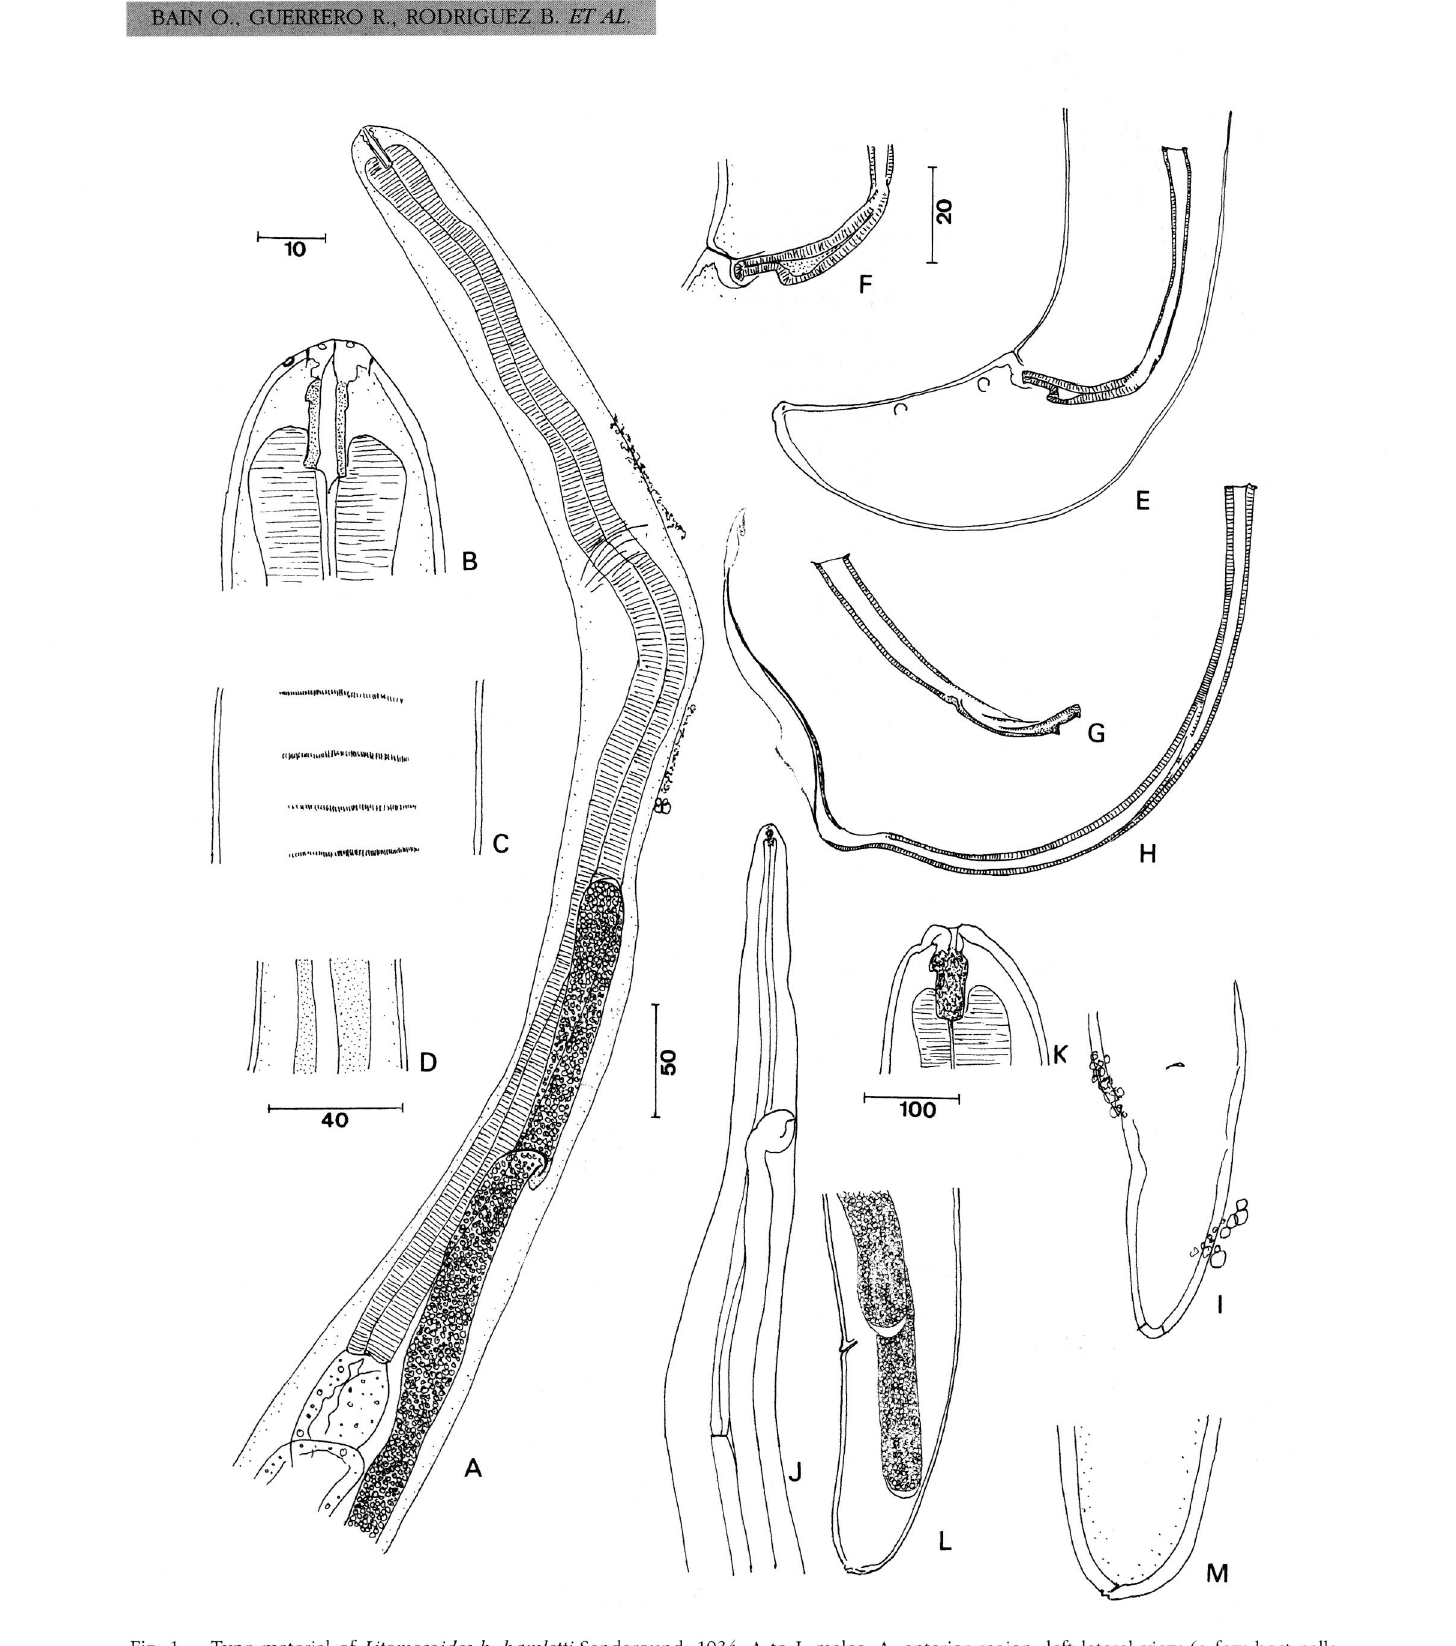
Fig. 1. - Type material of Litomosoides h. hamletti Sandground, 1934. A to I, males. A, anterior region, left lateral view (a few host cells are attached on the cuticle). B, head, median view. C, area rugosa. D, lateral chord and lateral thickening at level of nerve ring, lateral view. E, male tail and right spicule, left lateral view. F, distal region of right spicule, left lateral view. G, the other male, right spicule, right lateral view. H, left spicule of the male shown in A, left lateral view. I, tail, ventral view, second male (host cells are attached). J to M, female. J, anterior region, right lateral view. K, abnormally sclerotized buccal cavity and capsule. L, tail, left lateral view. M, caudal extre mity, left lateral view. Scale bars: A, L, 50 µm; B, F. 10 µm; C, E, G, H, K, I, M, 20 µm; D, 40 µm; J. 100